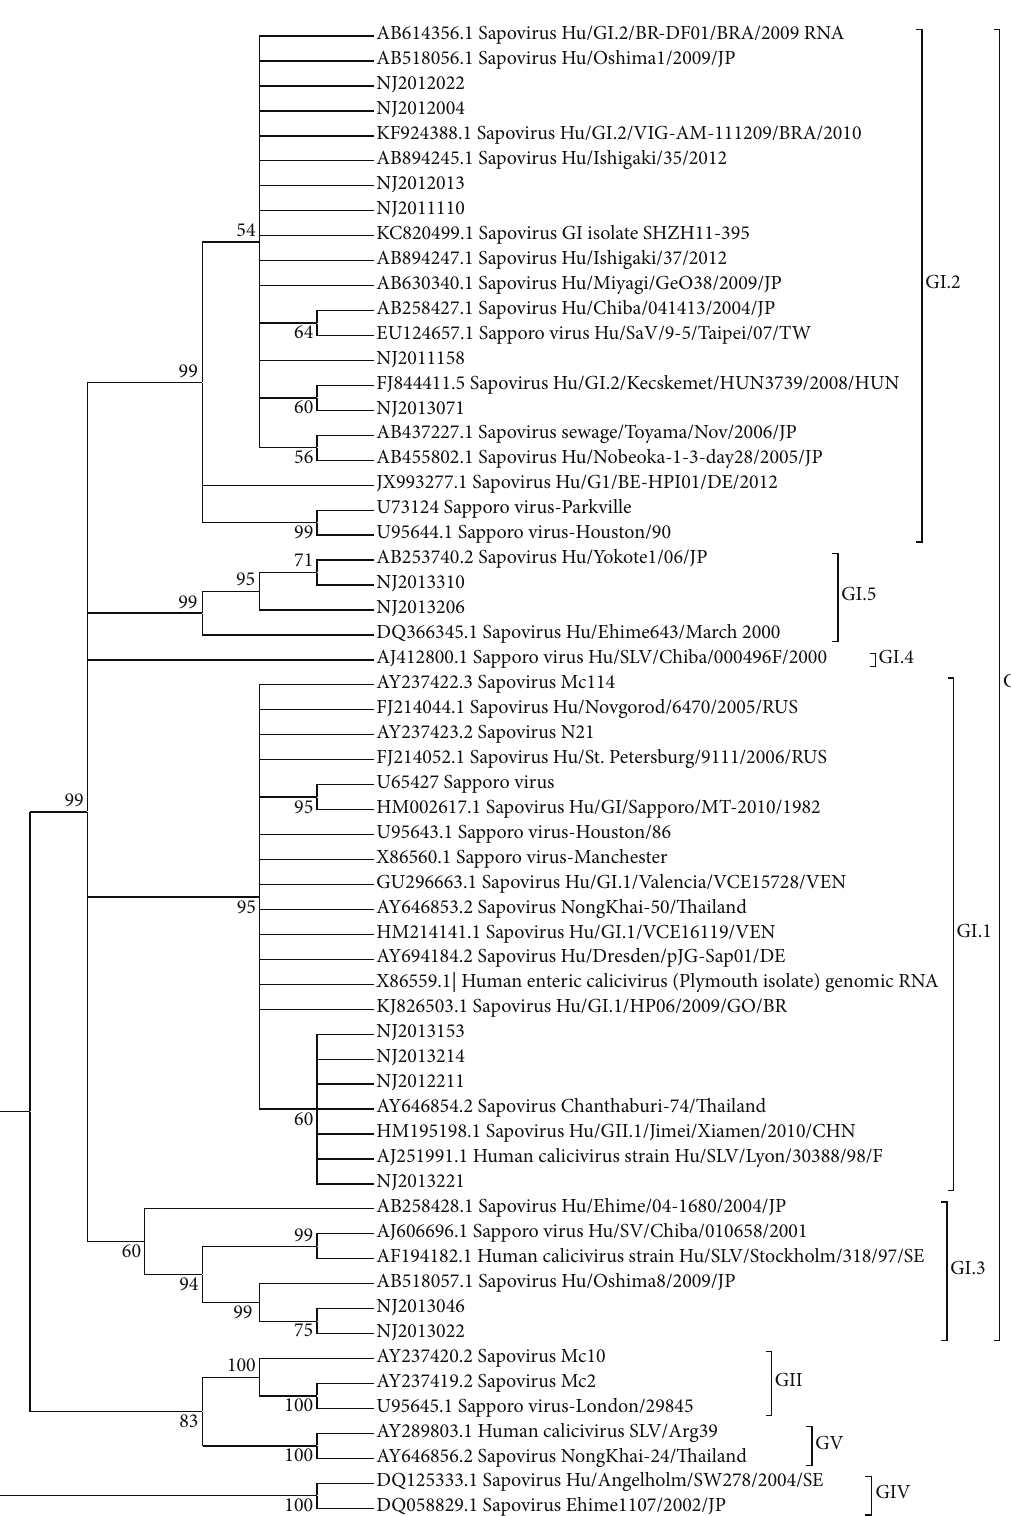
Figure 1: Phylogenetic analysis of the partial N terminal capsid gene (358 bp to 364 bp) of SaV strains identified in outpatients in Nanjing, China, between April 2011 and October 2013. The tree was constructed on the basis of the Kimura 2-parameter and neighbor-joining methods with MEGA5 software (http://www.megasoftware.net/) as described in Methods. The analysis involved 60 nucleotide sequences, 14 strains found in Nanjing presented as the year of detection and strain number, and 46 additional worldwide sequences presented with the NCBI accession number and details. GI, GII, GVI, and GV were genogroups, and GI.1, GI.2, GI.3, GI.4, and GI.5 were